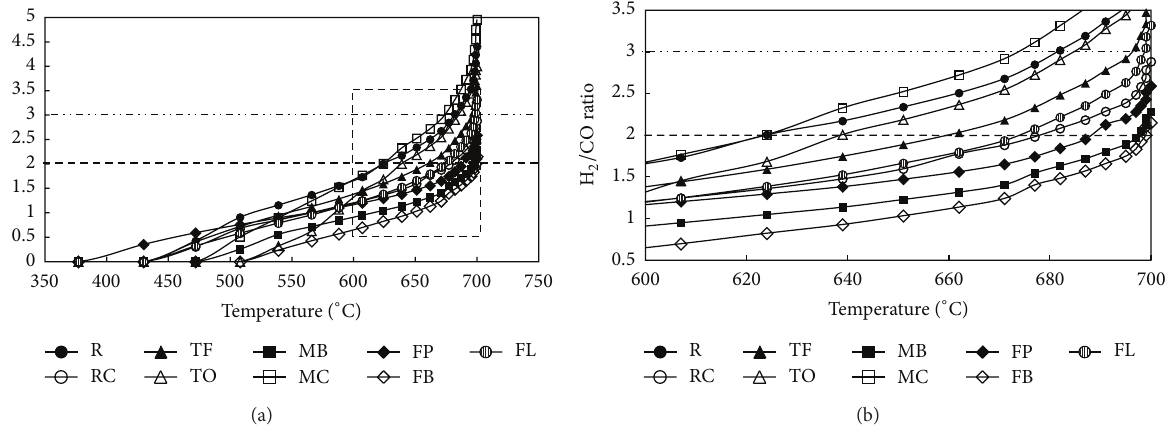
Figure 7: H 2 /CO ratio as a function of temperature.